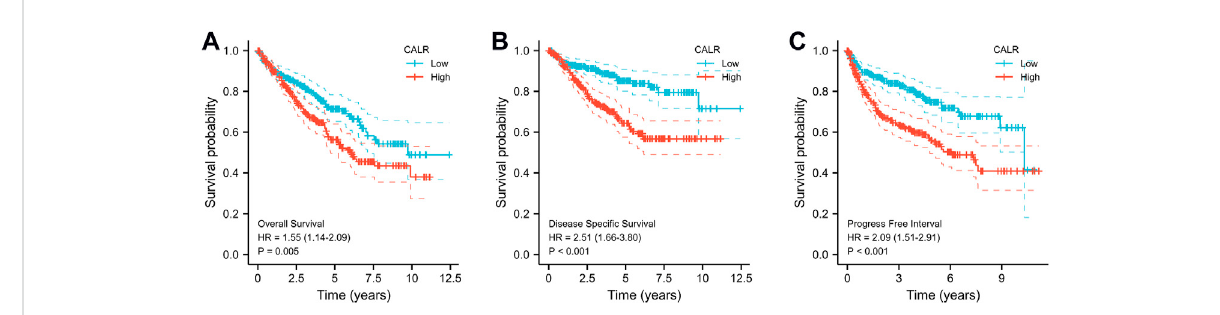
TABLE 2 Univariate and multivariate Cox regression analyses of clinical characteristics associated with the overall survival. Characteristic Total ( N ) Univariate analysis Multivariate analysis